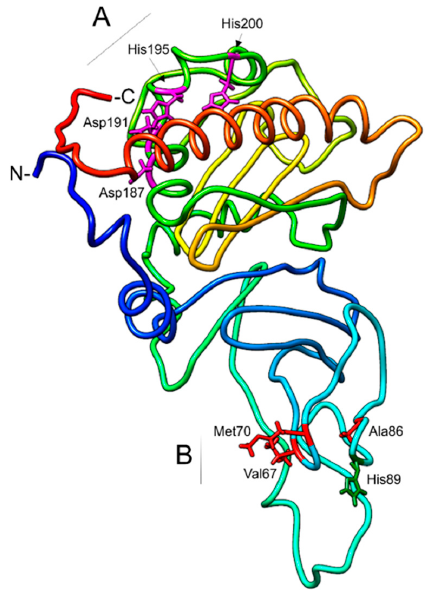
Figure 3. 3D-molecular model obtained for the putative protein product of TdCMO1a6 . In this model, the structure topology is shown. Regions A and B highlight the “non heme-motif” and “Rieske” motif, respectively.